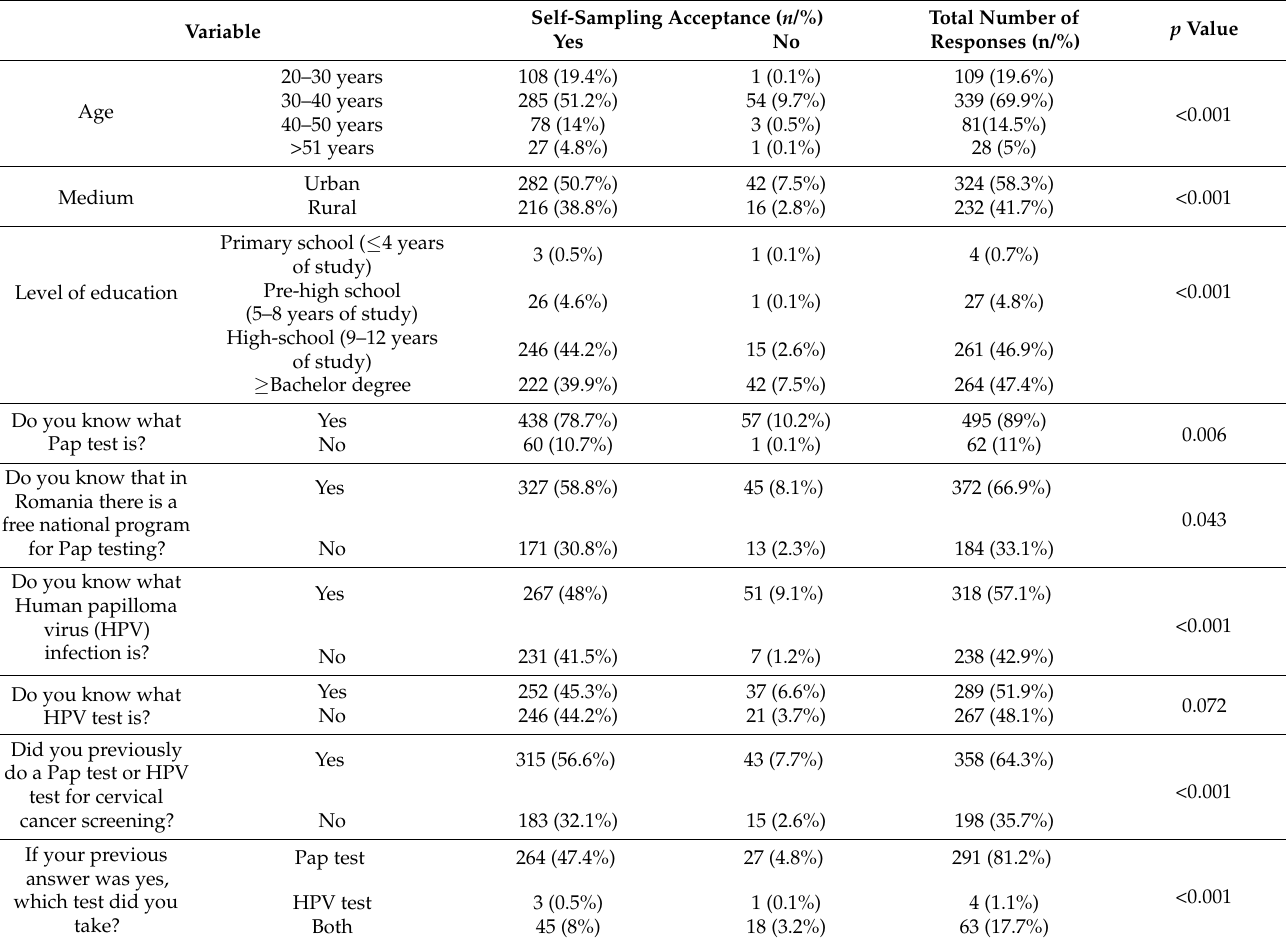
Table 1. The acceptability of vaginal HPV self-sampling among the respondents, considering the demographic characteristics and cervical cancer screening